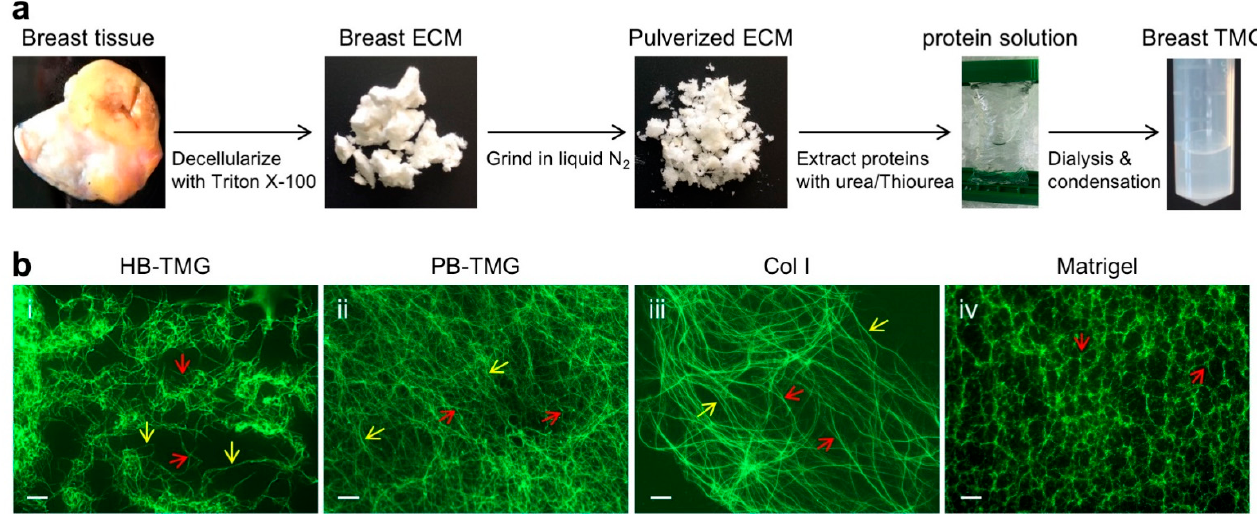
Figure 2. HB-TMG generation and microstructural differences from other ECM-derived hydrogels. ( a ) Flowchart for normal breast tissue ECM extraction and HB-TMG production. ( b ) Microscopic IF images of HB-TMG ( i ), PB-TMG ( ii ), Col I ( iii ), and Matrigel ( iv ) polymerized at the elastic moduli similar to native tissues. Red arrows, collagen fibers with connections or branches; yellow arrows, long collagen fibers. Scale bars, 10 μ m.